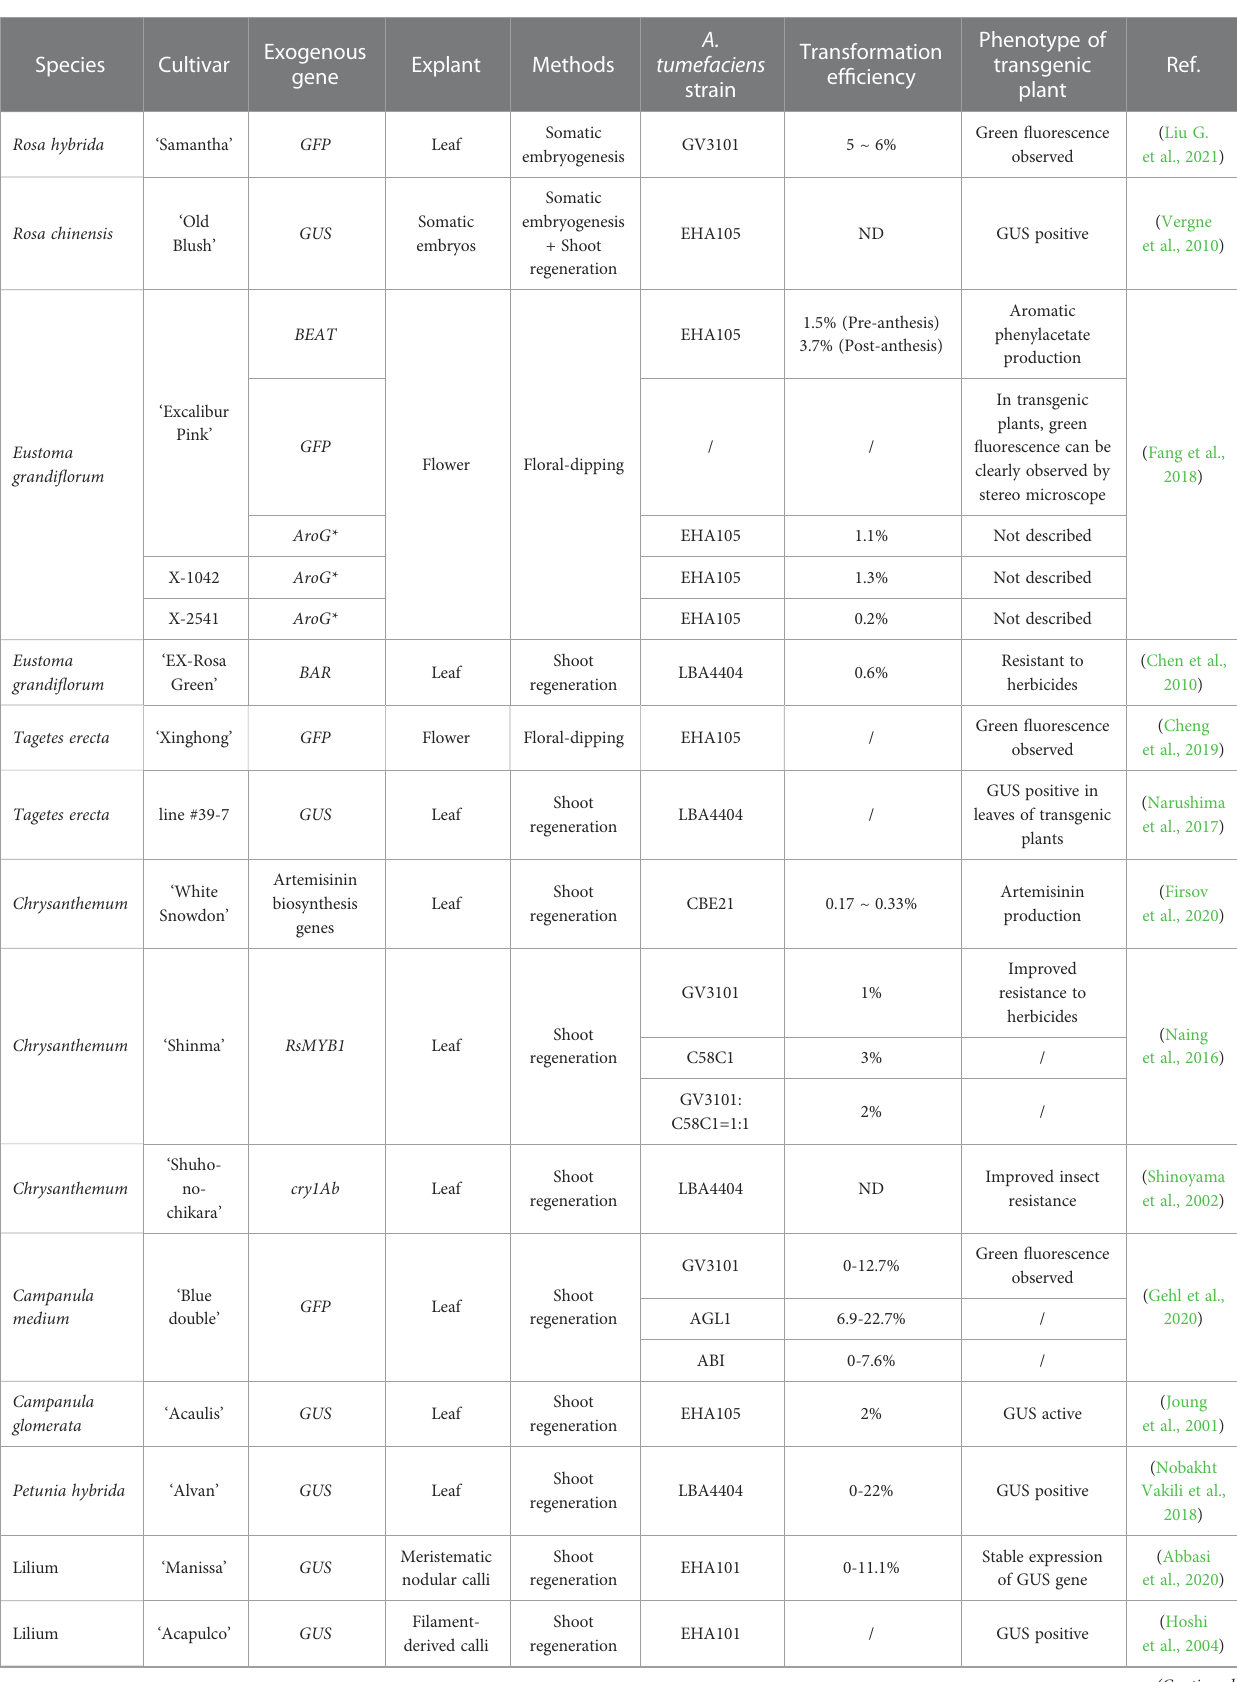
TABLE 1 Agrobacterium -mediated stable gene transformation in ornamental